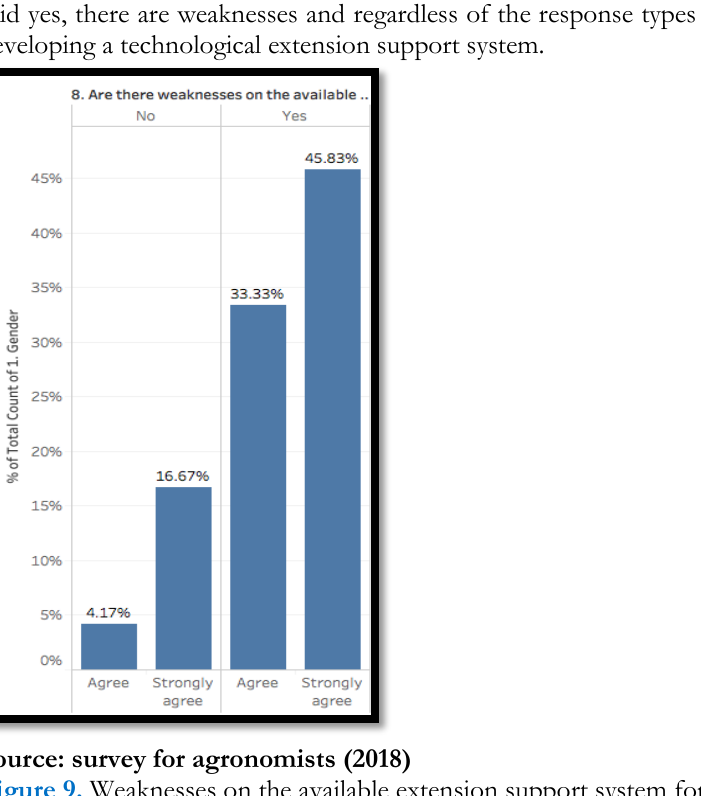
Figure 9. Weaknesses on the available extension support system for small holder